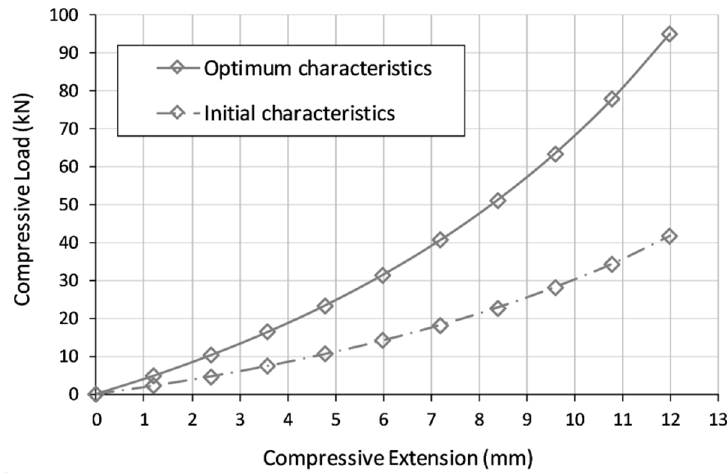
Figure 2. Working characteristics of a rubber bumper with optimum shape and a possible initial shape.